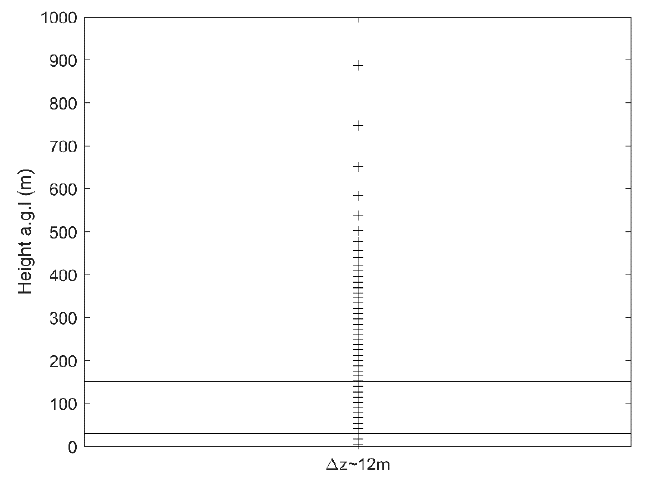
Figure 1. Elevation map ( a ) and hypothetical wind farm layout with black dots ( b ). Of the nested domains, the innermost domain indicated in red has a horizontal resolution of 1 km and shows the location of the elevation map ( c ). Δx, ITS, Δh, and Δd in the wind farm layout plot ( b ) represent the horizontal resolution, inter-turbine spacing, elevation difference, and distance between the measurement location (black asterisk) and the location of the closest cell-centered model grid point (red asterisk), respectively.